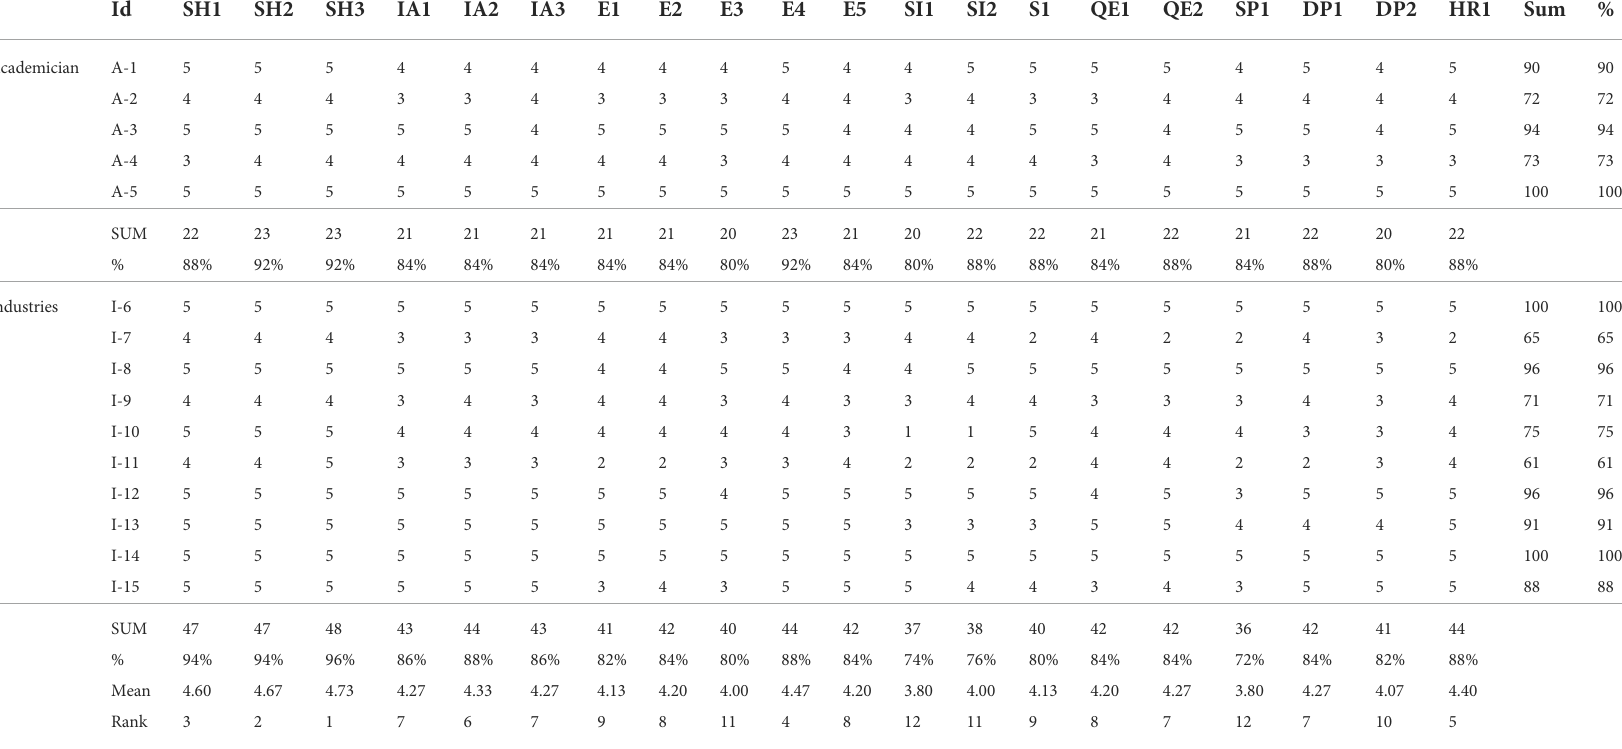
TABLE 4 Weighted Means and Ranks for Social Sustainability Attributes based on Real Project